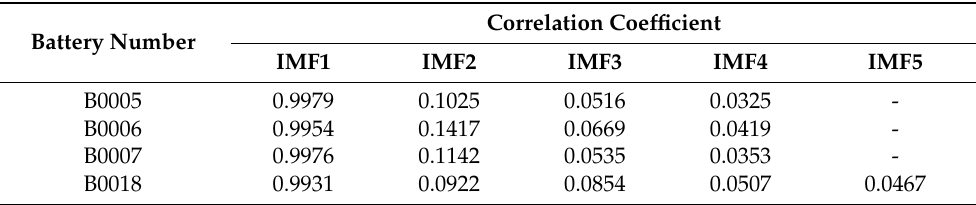
Table 3. Correlation coefficient between IMFS and measured capacity data for each battery group. Battery Number